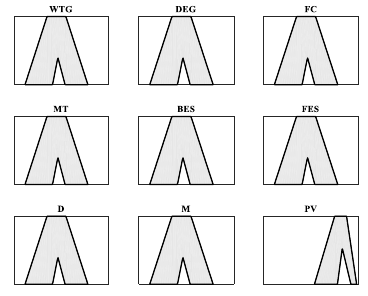
Figure 8. Interval Type II fuzzy model of microgrid’s